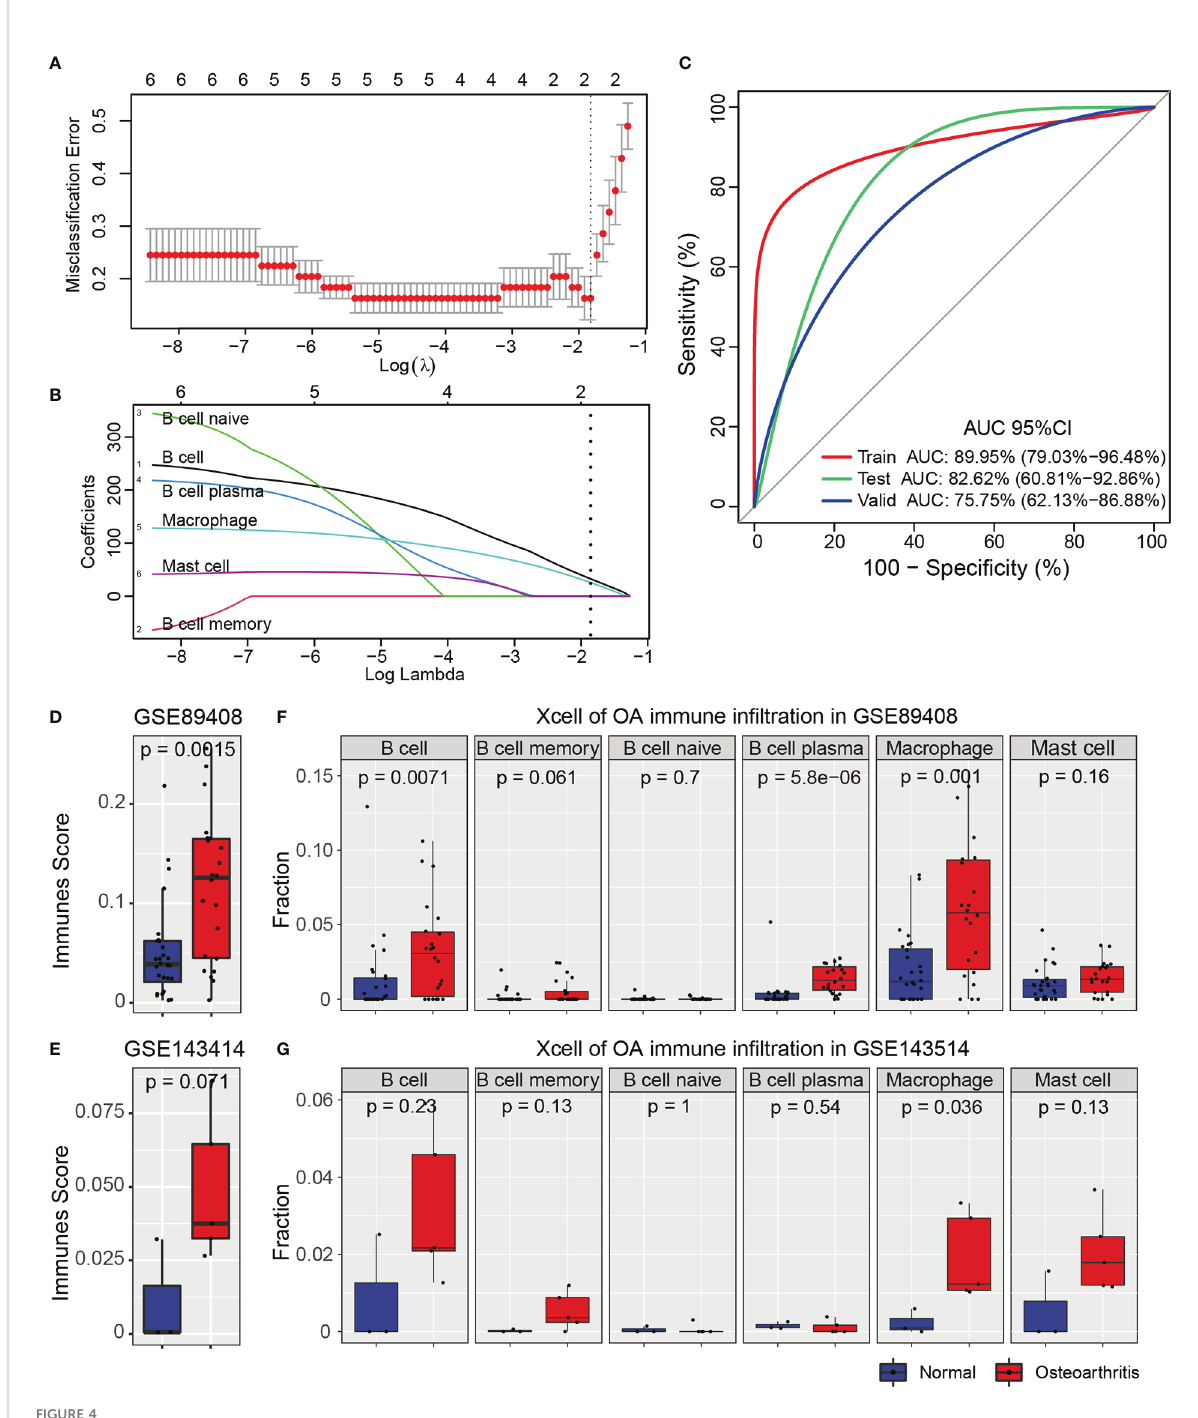
FIGURE 4 LASSO analysis for immune in fi ltration cell types. (A) CV statistical graph during the construction of the LASSO regression model, which shows that the minimum lambda at model construction is 0.1614863. (B) The model regression coef fi cient diagram shows the change trend of the coef fi cient corresponding to each immune in fi ltrating cells variable with the change of lambda value. (C) ROC curve predicts the identi fi cation effect of the above models in different datasets. The closer AUC value is to 1, the better of prediction effect on the model. The fi gure is shown that the AUC in the training set is 0.8995 and that, in the test, set is 0.8262, indicating that the model has a robust prediction accuracy. In the validation datasets, the AUC is 0.7575, which shows that the models constructed by the Macrophage and B cell can also have good accuracy in different types of datasets. (D, E) The immune score of GSE89408 and GSE143514 datasets. The fi gure shows that immune sore is signi fi cantly increased in the two datasets. (F, G) The immune in fi ltration analysis of six cell types in GSE89408 and GSE143514